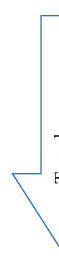
Figure 1: Hierarchical order of the brain areas relevant in this work. EBA: extrastriate body area; S1: primary somatosensory cortex; M1: primary motor cortex; IPS: intraparietal sulcus; PMC: premotor